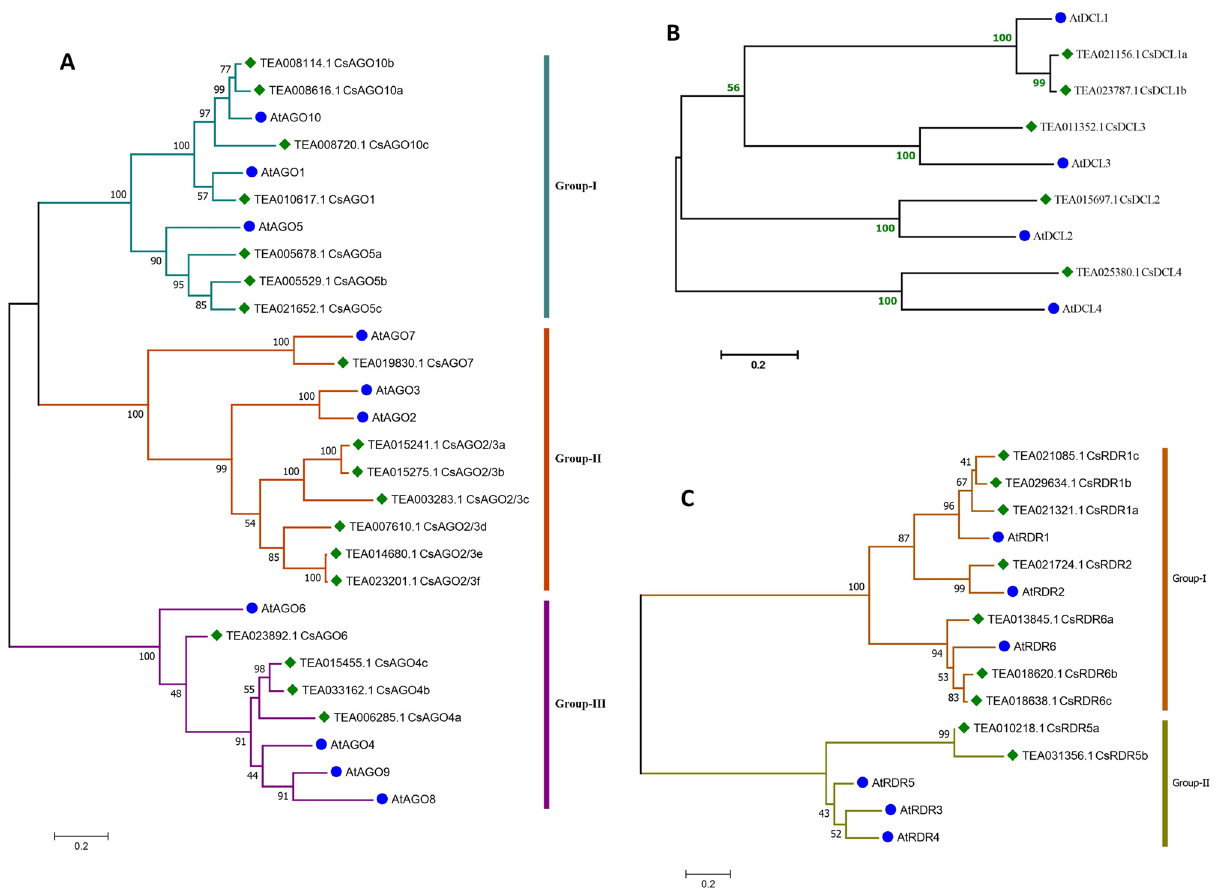
Figure 1. Phylogenetic trees showing relationships between ( A ) AGOs, ( B ) DCLs and ( C ) RDRs of C. sinensis and A. thaliana. The trees were constructed using the maximum likelihood method and a bootstrap replicate of 1000. The trees with the highest bootstrap support for each gene class have been shown